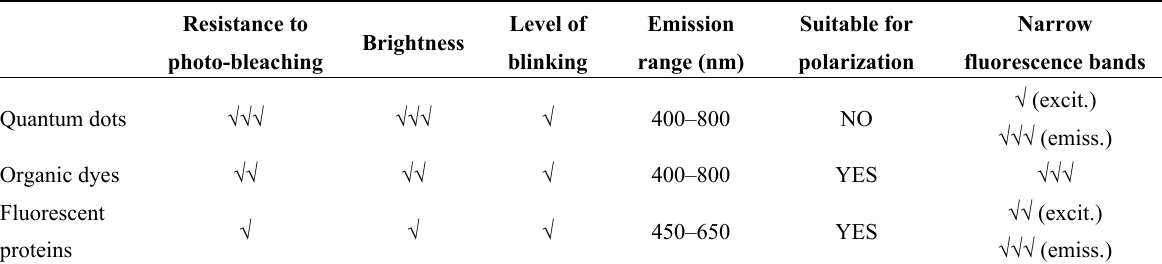
Table 1. Characteristics of fluorescent